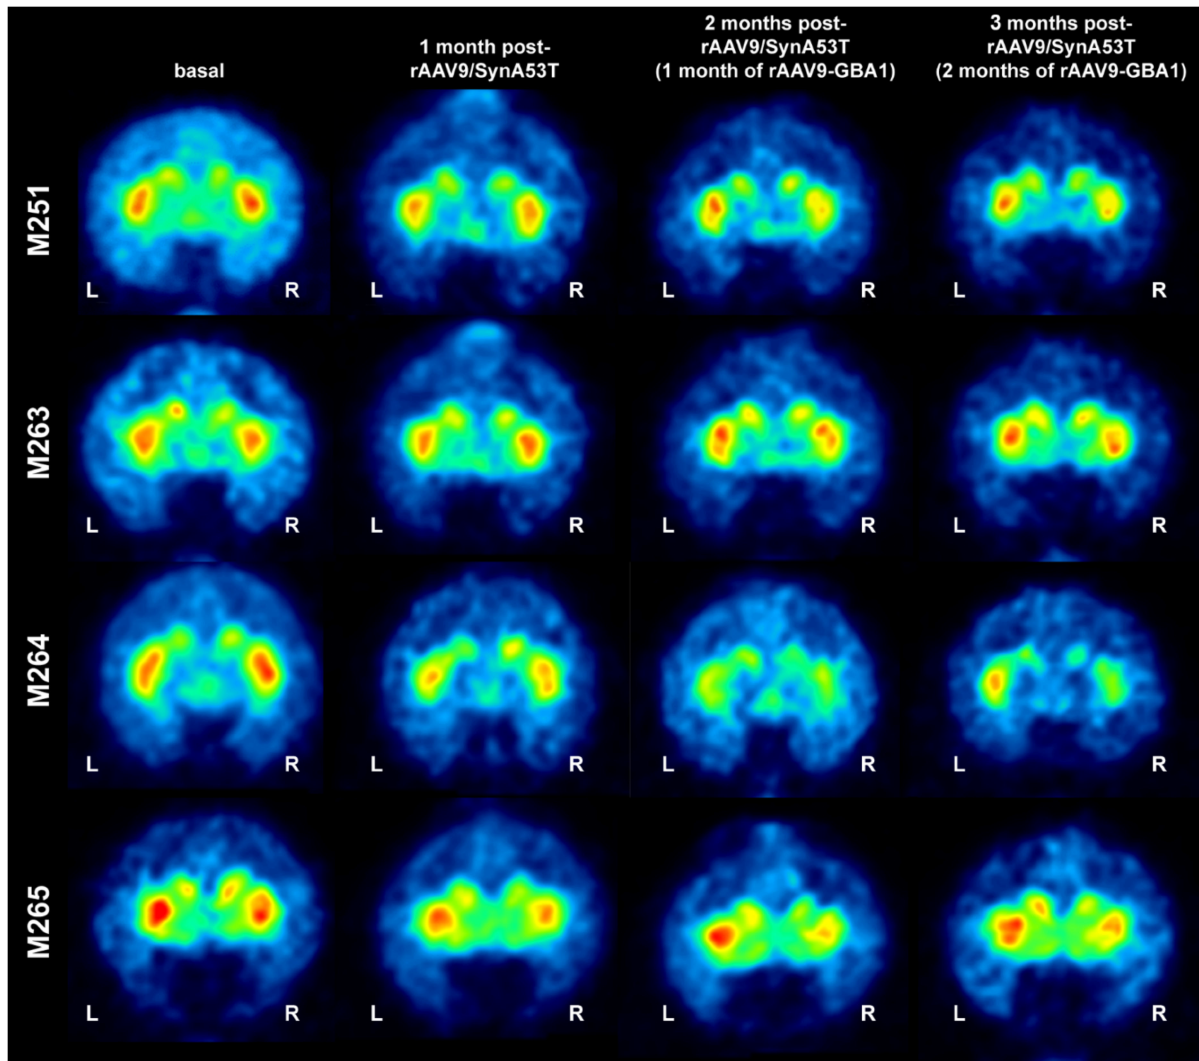
Figure 3. MicroPET follow-up of NHPs. Representative coronal images taken at the level of the post-commissural caudate and putamen nuclei for all the 4 NHPs included in the study. MicroPET scans with 11 C-DTBZ were taken at baseline, and 1, 2 and 3 months post-bilateral delivery of rAAV9-SynA53T. Compared to baseline radiotracer uptake levels, a bilateral decline is observed in all animals one month post-injection of rAAV9-SynA53T. One month later (e.g., 2 months posttreatment with rAAV9-SynA53T and 1 month post-injection of rAAV9-GBA1 in the left SNpc and rAAV9-null in the right SNpc), an asymmetrical pattern of radiotracer uptake is noticed in all animals with the only exception of M263. MicroPET scans were repeated one month later (3 months of rAAV9-SynA53T, including 2 months of rAAV9-GBA1 and rAAV-null), evident left vs. right differences in radiotracer uptake were observed in all animals. When compared to baseline levels, observed differences with a follow-up of 3 months failed to reach statistical